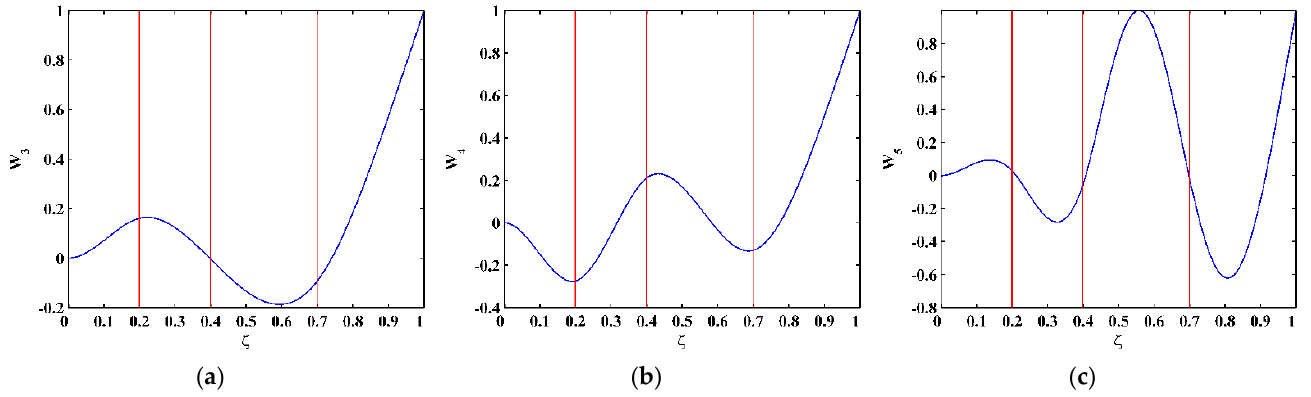
Figure 4. The ( a ) third, ( b ) fourth, and ( c ) fifth mode shapes (locations of cracks are indicated by red lines).